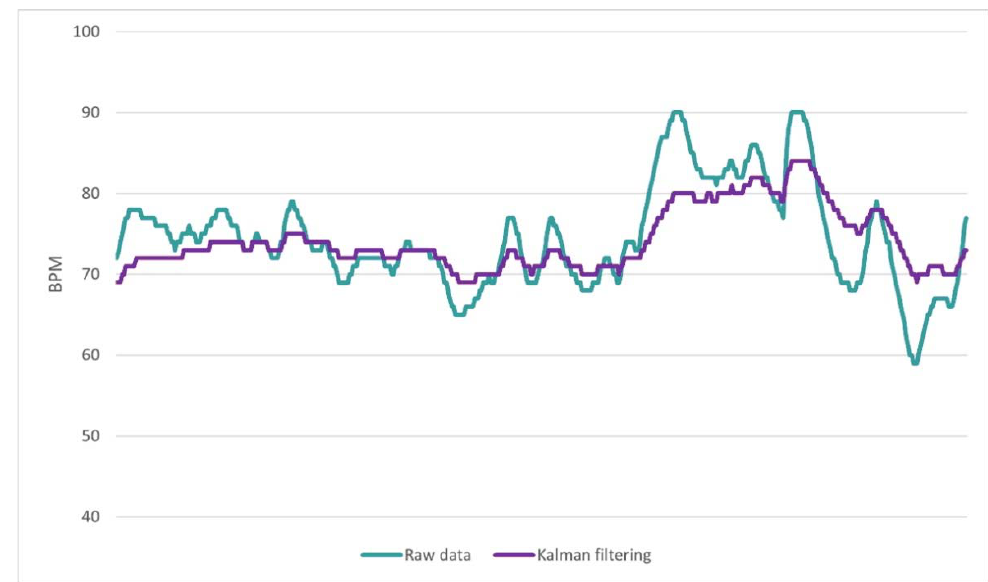
Figure 7. Application of the Kalman filtering algorithm to BPM data that are derived from the PPG signal. The green line depicts the raw data that are obtained from the sensor, before the preprocessing, while the magenta line depicts the same data after the application of Kalman filtering.